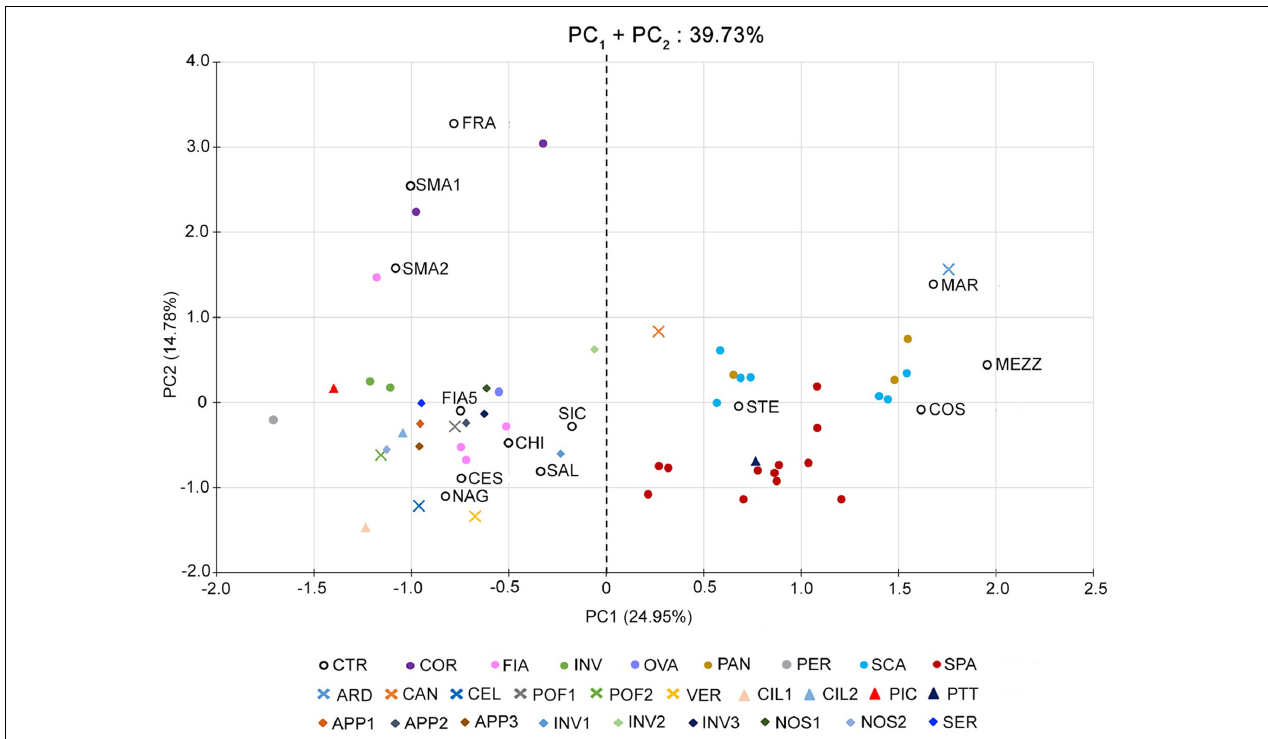
FIGURE 1 | Multivariate analysis of the phenotypic variability of the 64 analyzed tomato genotypes. Scatter plot of the first (PC1) and second (PC2) principal components showing the variation for 25 vegetative and reproductive traits. Accessions are represented by differently colored symbols, as indicated in the legend. Accessions’ abbreviations are listed in Supplementary Table 1 . The black dotted line at the zero divides the flat-type accessions (on the right ) from the non-flat ones (on the left